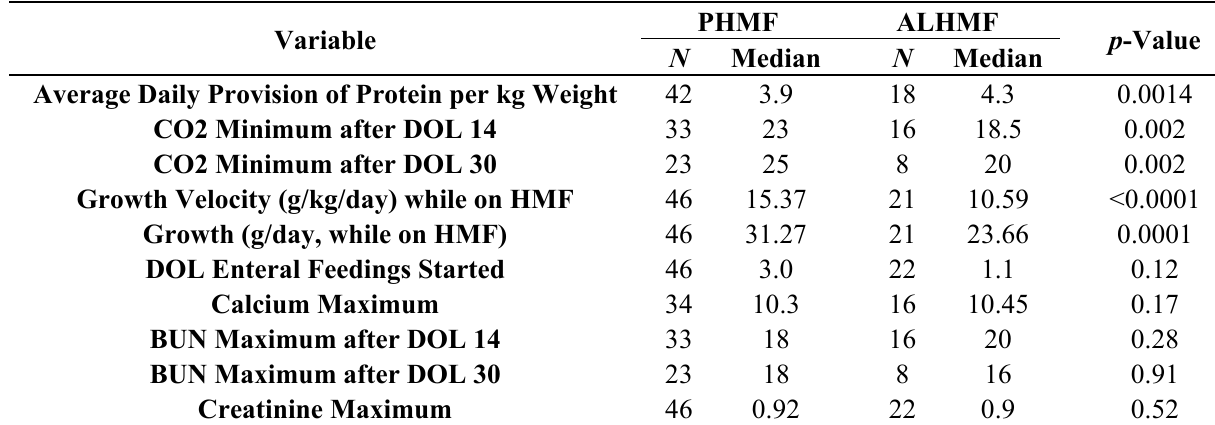
Table 3 . Enteral feeding, growth and laboratory data.